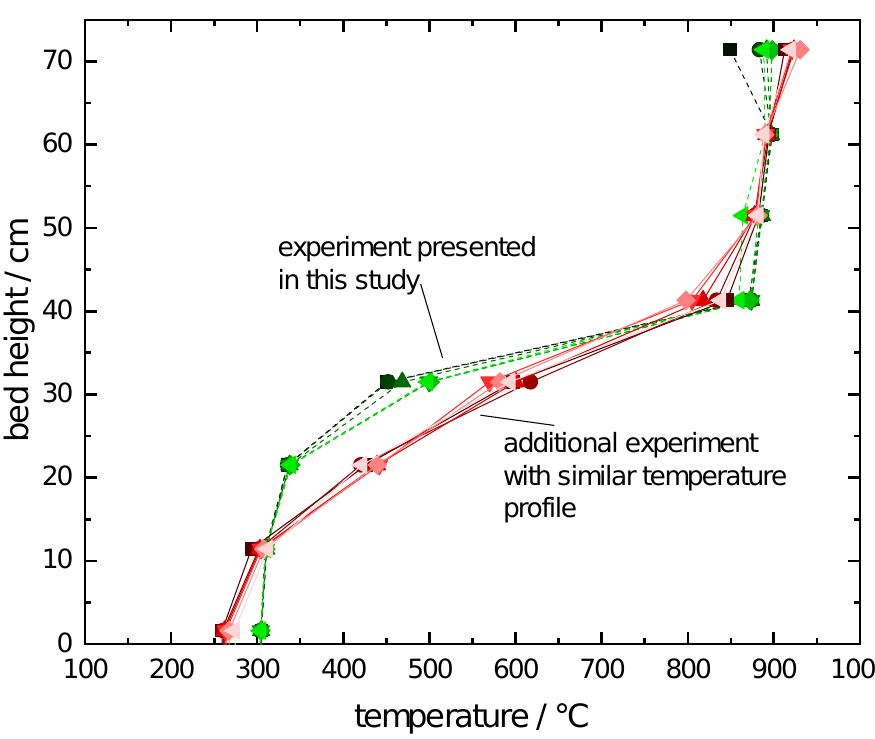
Figure A3. Development of the temperature of 6 particle layers (in 2cm distance to each other) along the bed height during moving bed operation of the experiment in the study (green dotted lines, compare to Figure 7) and a similar experiment (red solid